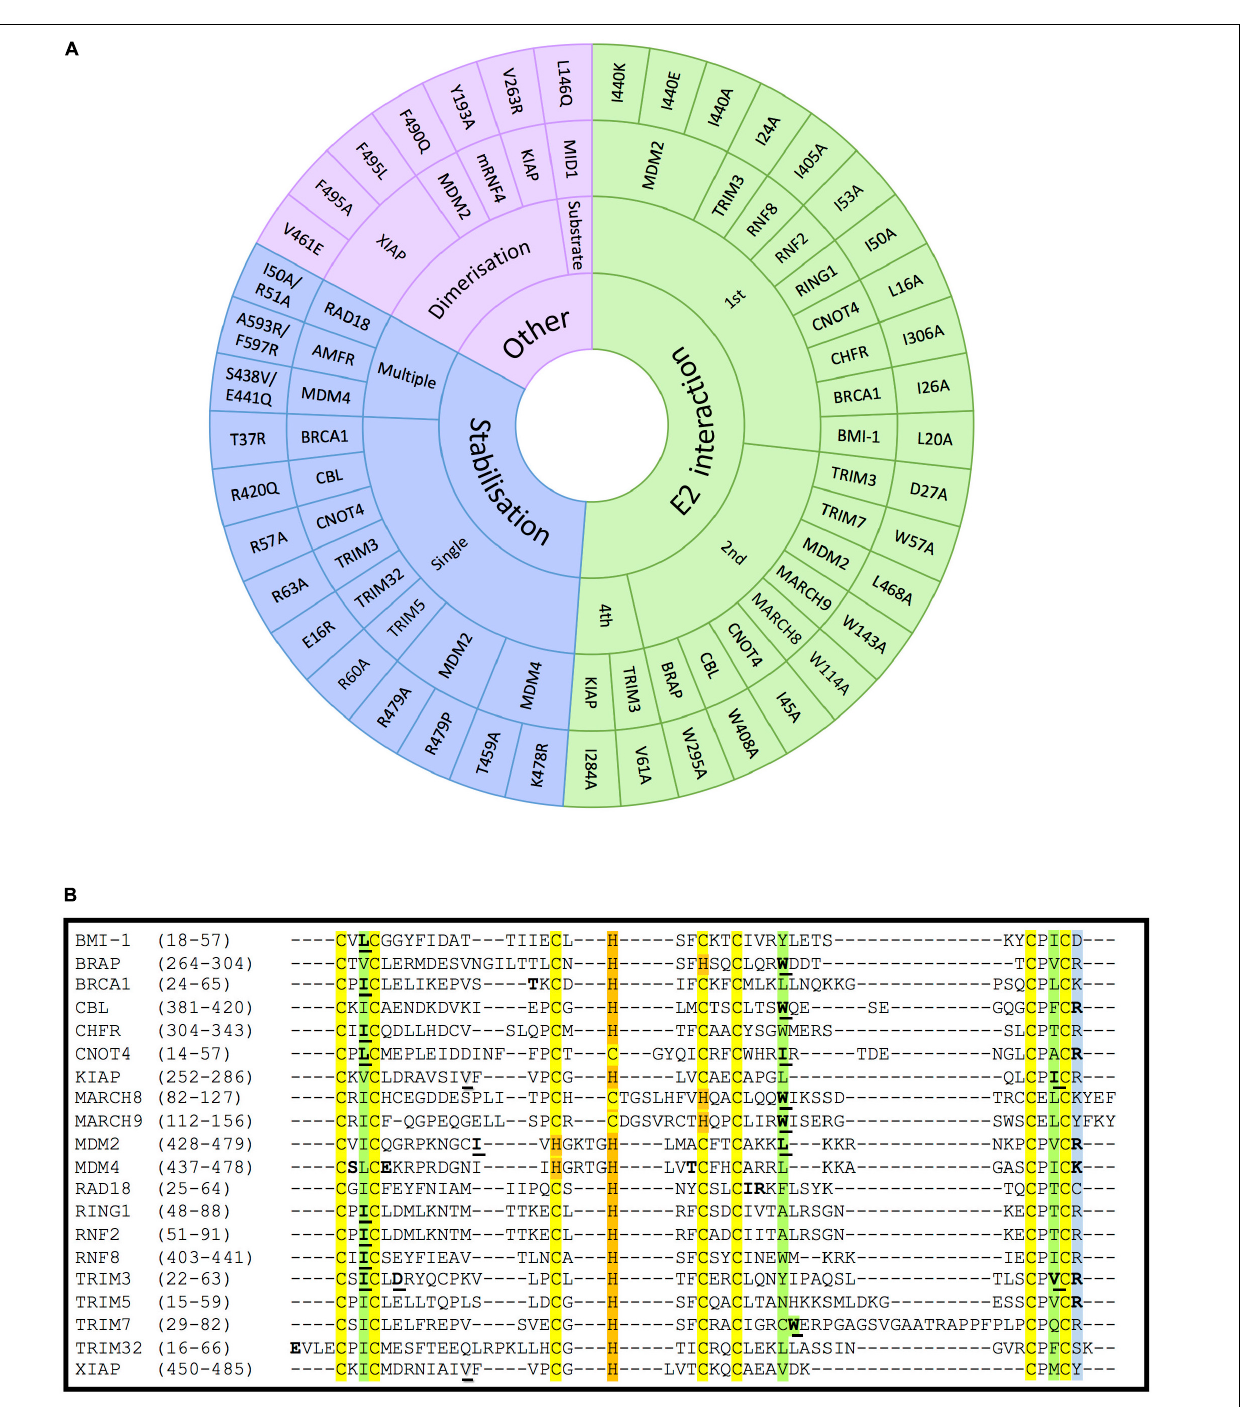
FIGURE 4 | Mutations on RING- and RBR-type E3s that affect E2-interaction, domain stabilisation, protein dimerization or substrate recognition. (A) In RING-type E3 ubiquitin ligases, inactivation can be obtained by abolishing the interaction with E2 ubiquitin-conjugating enzymes (green). This has mostly been achieved by mutating the conserved 1st (I/L) and 2nd (W/I/L) hydrophobic residues indicated in Figure 2 . Other mutations affecting the stabilisation of key residues of the domain (blue), dimerization or the interaction with a specific substrate also abolish the ligase activity (purple). For the stabilisation affecting mutations, those have been classified whether a unique (single) or various (multiple) residues were mutated simultaneously. References to all the mutations shown in this figure are provided in Supplementary Table S1 . (B) Alignment of the RING domains of the RING-type E3 ligases involved in E2-interacting and stabilisation mutations within the RING domain. Conserved amino acids are highlighted in yellow and orange, respectively, for the Zn-coordinating Cys and His residues, and in green for the E2-interacting residues. The conserved positively charged residues at the end of the RING domain are highlighted in blue. Mutated E2-interacting residues are shown in bold and underlined. Mutated residues involved in stabilisation are shown in bold. Mutated residues involved in dimerisation are underlined and shadowed.